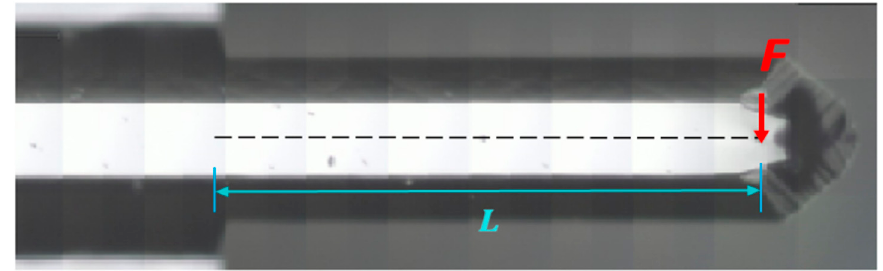
Figure 1. The tested area of the AFM cantilever across its length.